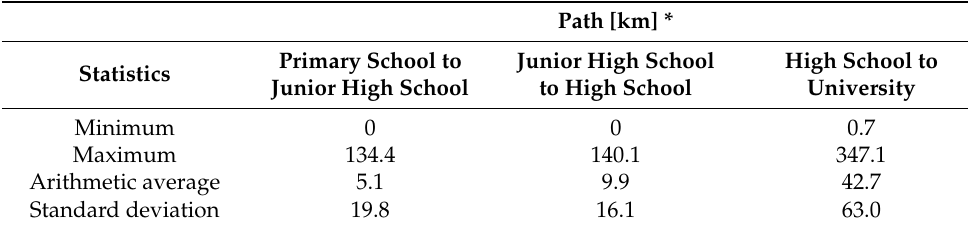
Figure 8. The geographical educational path of the students, on the map within Łódź ( A ) Lodzkie Voivodeship ( B ) and in Poland, excluding Lodzkie Voivodship ( C ). Table 2. Descriptive statistics on the geographical educational path of the